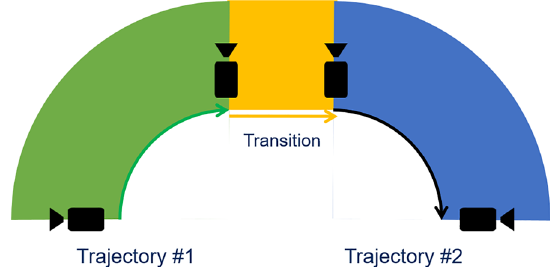
Fig. 9 The conventional trajectory design idea, where the images of transition are necessary for continuity. Green: Trajectory #1; Orange: Transition; Blue: Trajectory